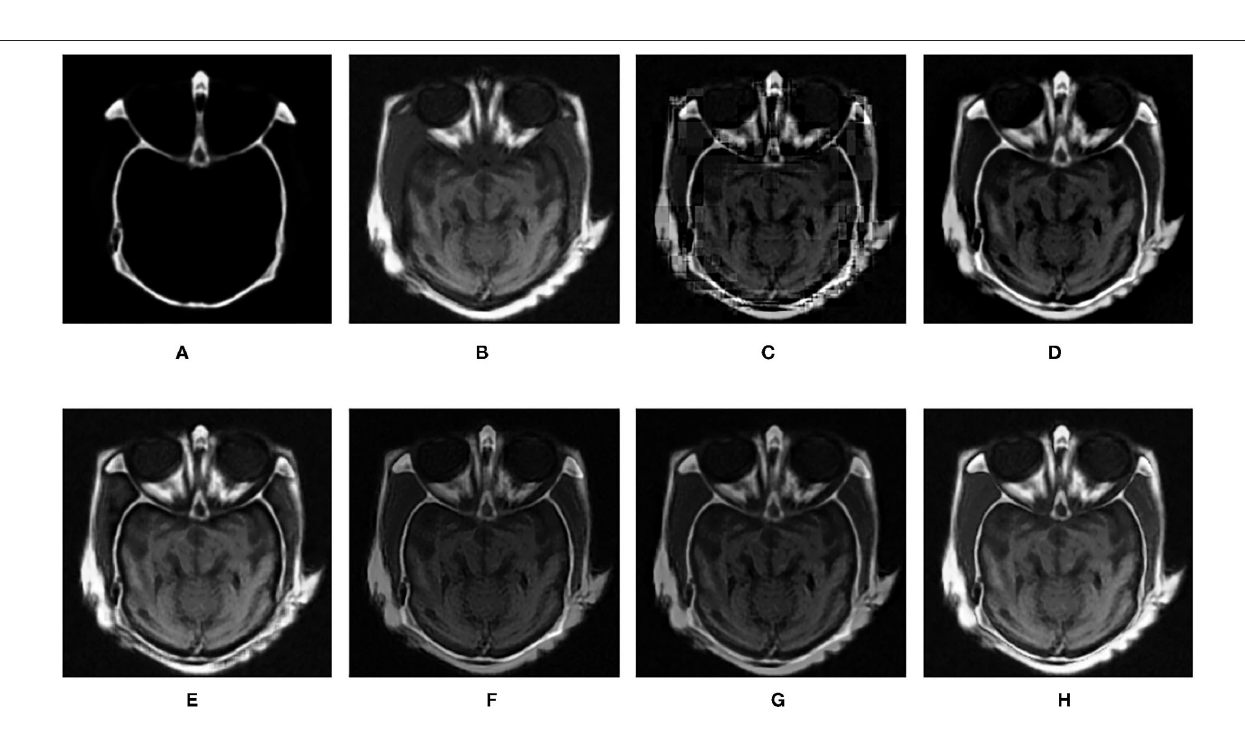
Frontiers in Neurorobotics |